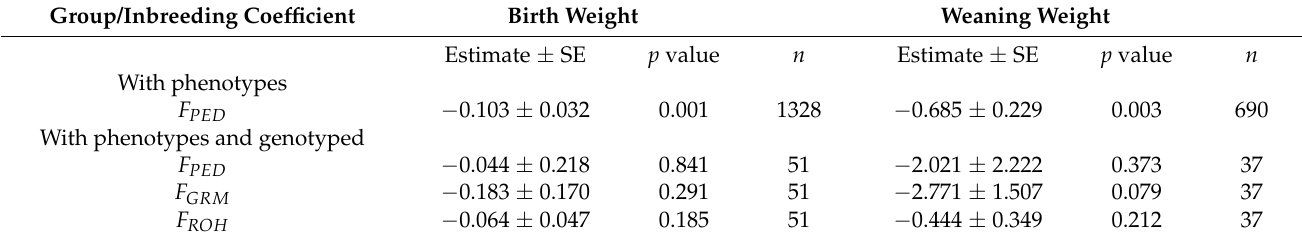
Table 6. Estimates of the regression coefficients of pedigree inbreeding ( F PED ) , genomic inbreeding based on the genomic relationship matrix ( F GRM ) and based on runs of homozygosity ( F ROH ) on birth weight and weaning weight. Group/Inbreeding